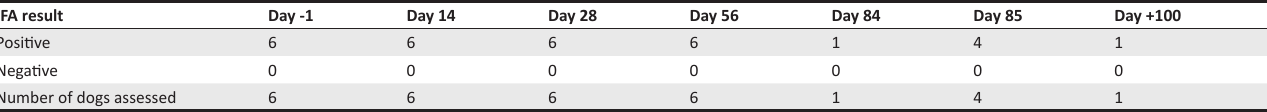
PCR, polymerase chain reaction. TABLE 5: Number of animals for which the indirect immunofluorescence assay results on the respective study days (Days) indicated presence of Ehrlichia canis antibodies. IFA